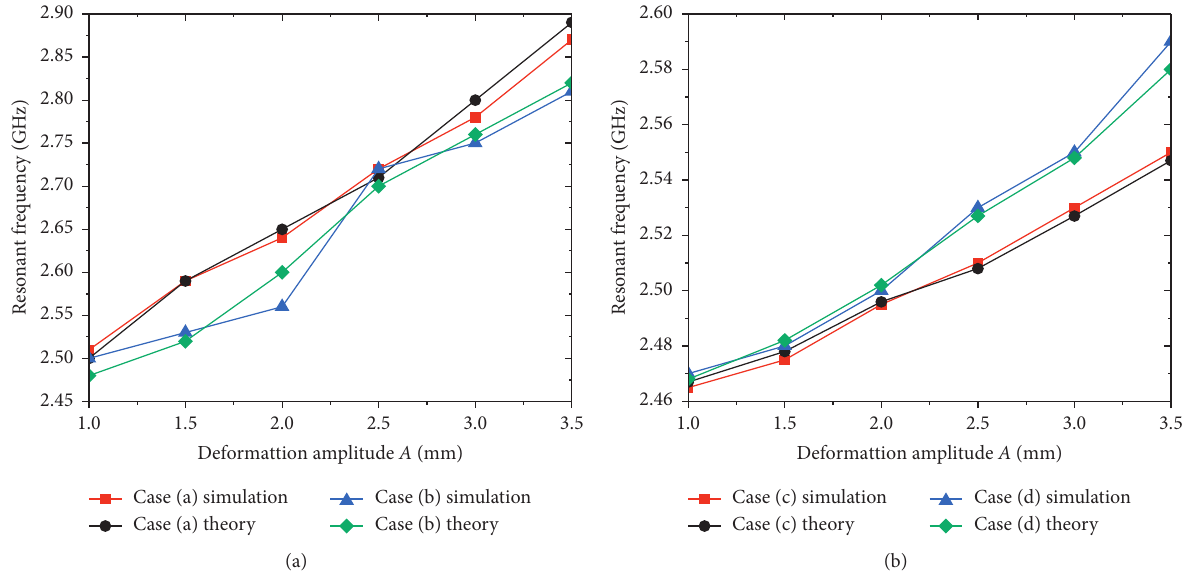
Figure 8: Comparison between simulation and theoretical results of resonant frequency. (a) XOZ plane deformation and (b) YOZ plane